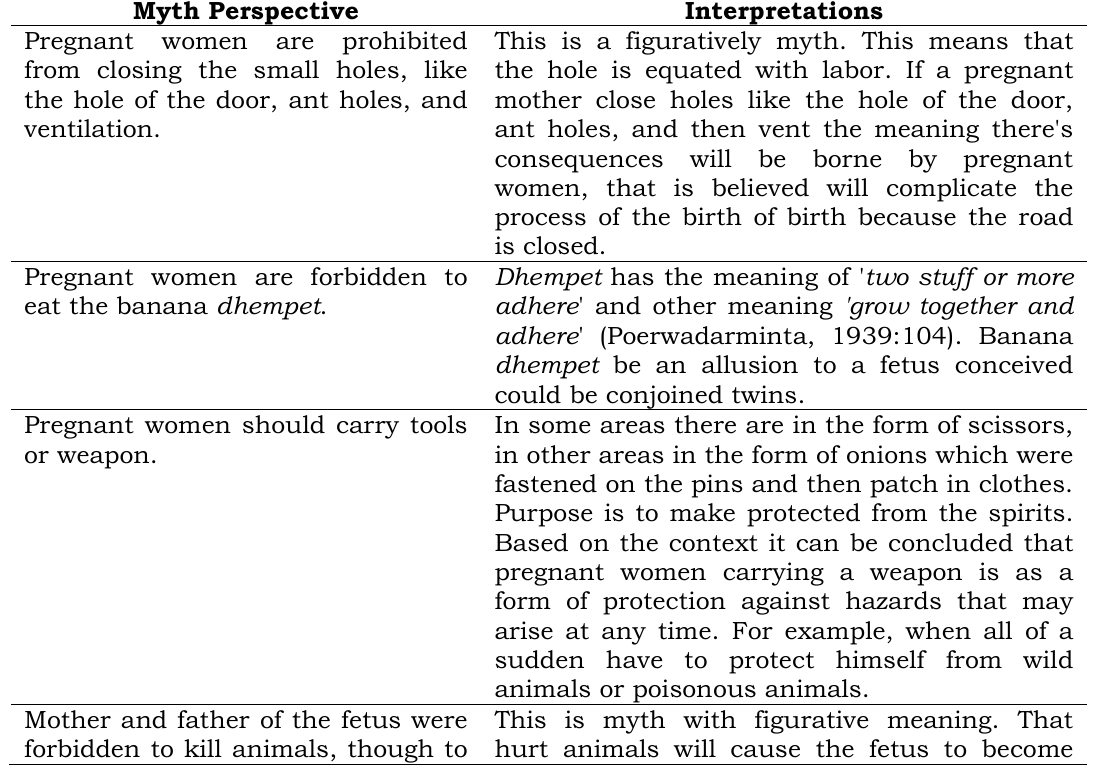
Table 1. The Results of the